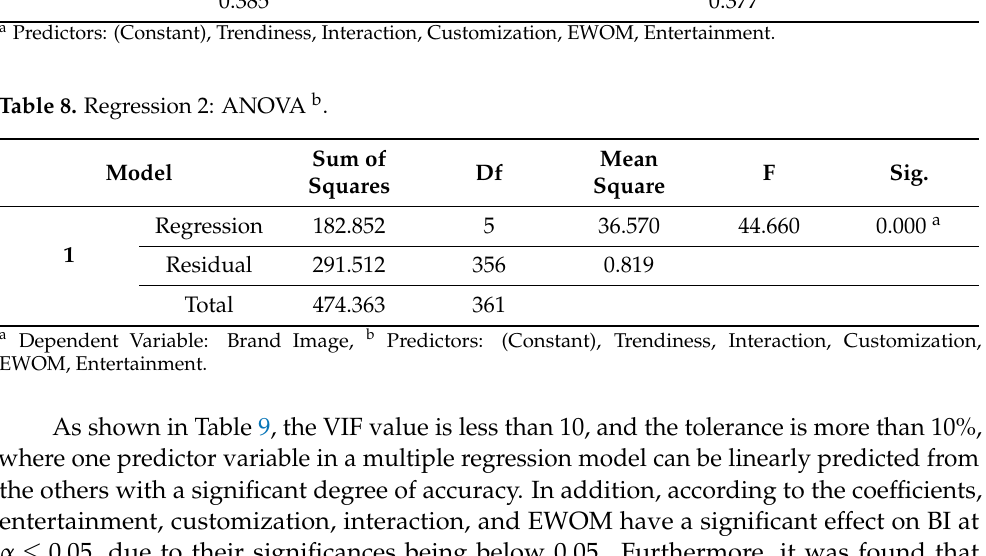
Table 7. Regression 2: Brand Image and SMA a . R Square